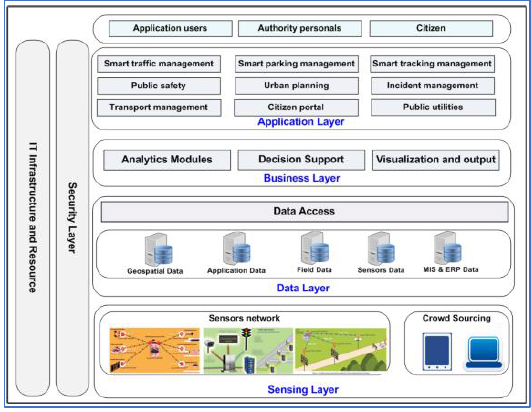
Figure_3: Architecture for the